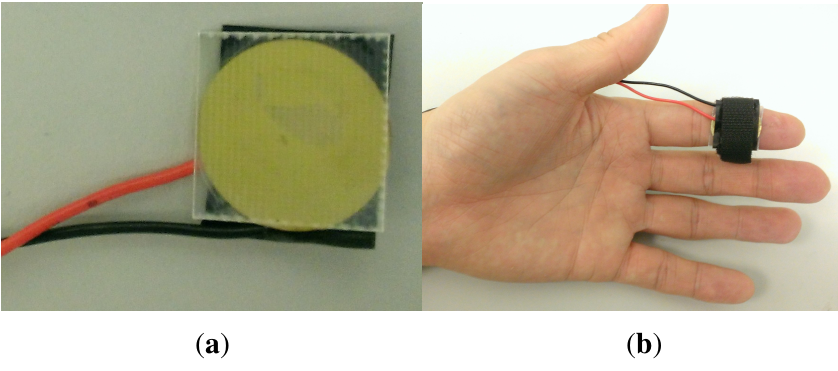
Figure 15. Identification experiment setup to investigate identifiable frequencies for tactile feedback: ( a ) Piezoelectric actuator and ( b ) the actuator attached to the